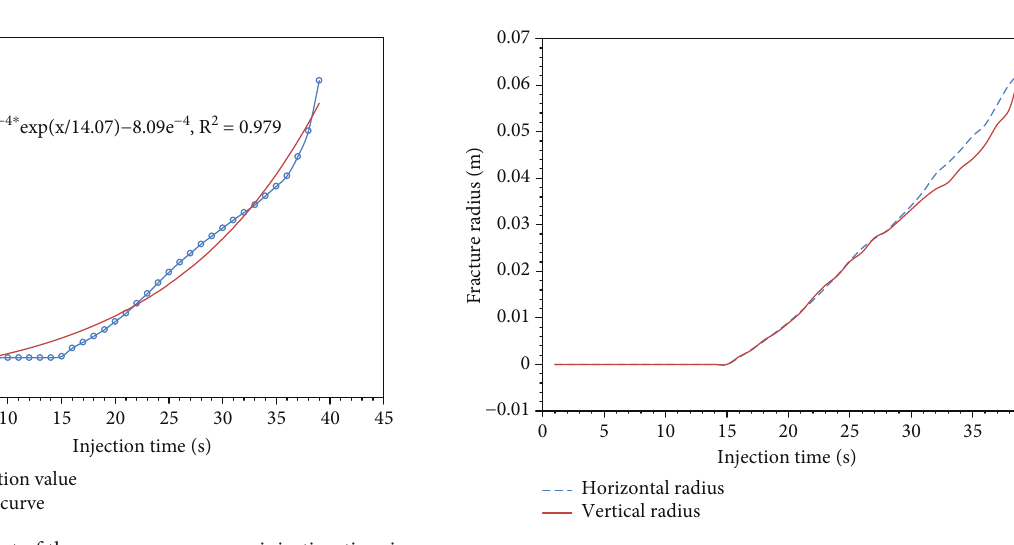
Figure 7: Development of horizontal and vertical fracture radii versus injection time in the intact